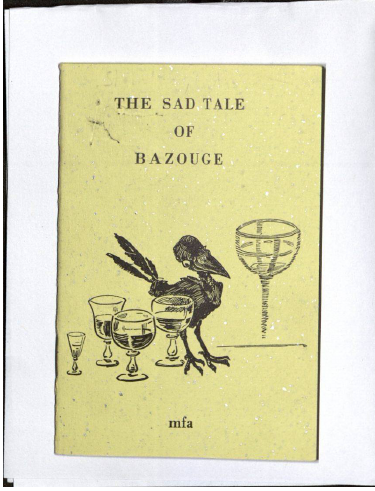
Figure 4. Steinlen T.A. (1961), The Sad Tale of Bazouge , Museum of Fine Arts, Boston.